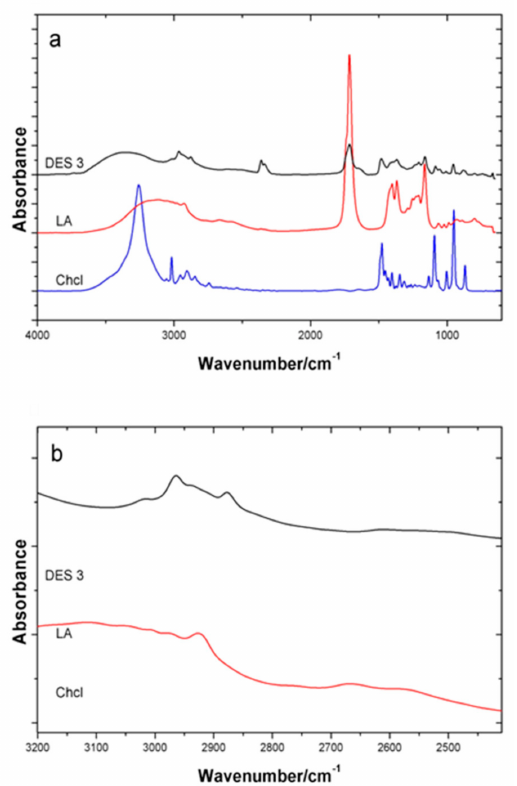
Figure 6. FT-IR spectra of ChCl, LA and DES3 (( a ), original figure, ( b ) local amplification